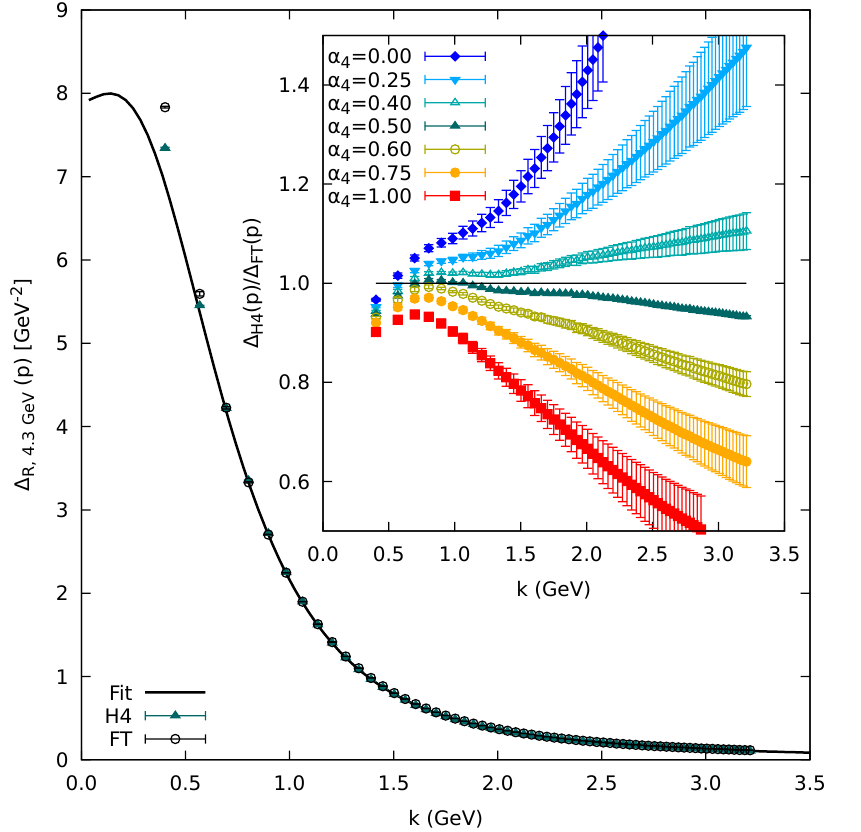
Figure 5. Gluon propagator in momentum space renormalized at µ = 4 . 3GeV as a function of the momentum for the H4 extrapolated data in momentum space (purple full squares) and from the continuum Fourier transform of the position-space ones (open green circles). For comparison, the parametrization proposed in [19] has been represented as the full line. The inset shows the ratio of the bare gluon propagators obtained from the application of H4 extrapolation in momentum space and the one coming from the Fourier transform of x-space ones. Each set corresponds to a different value of α for the extrapolations in position space (from top to bottom α 4 α 4 = 1 / 2 , α 4 = 3 / 4 , and α 4 = 1